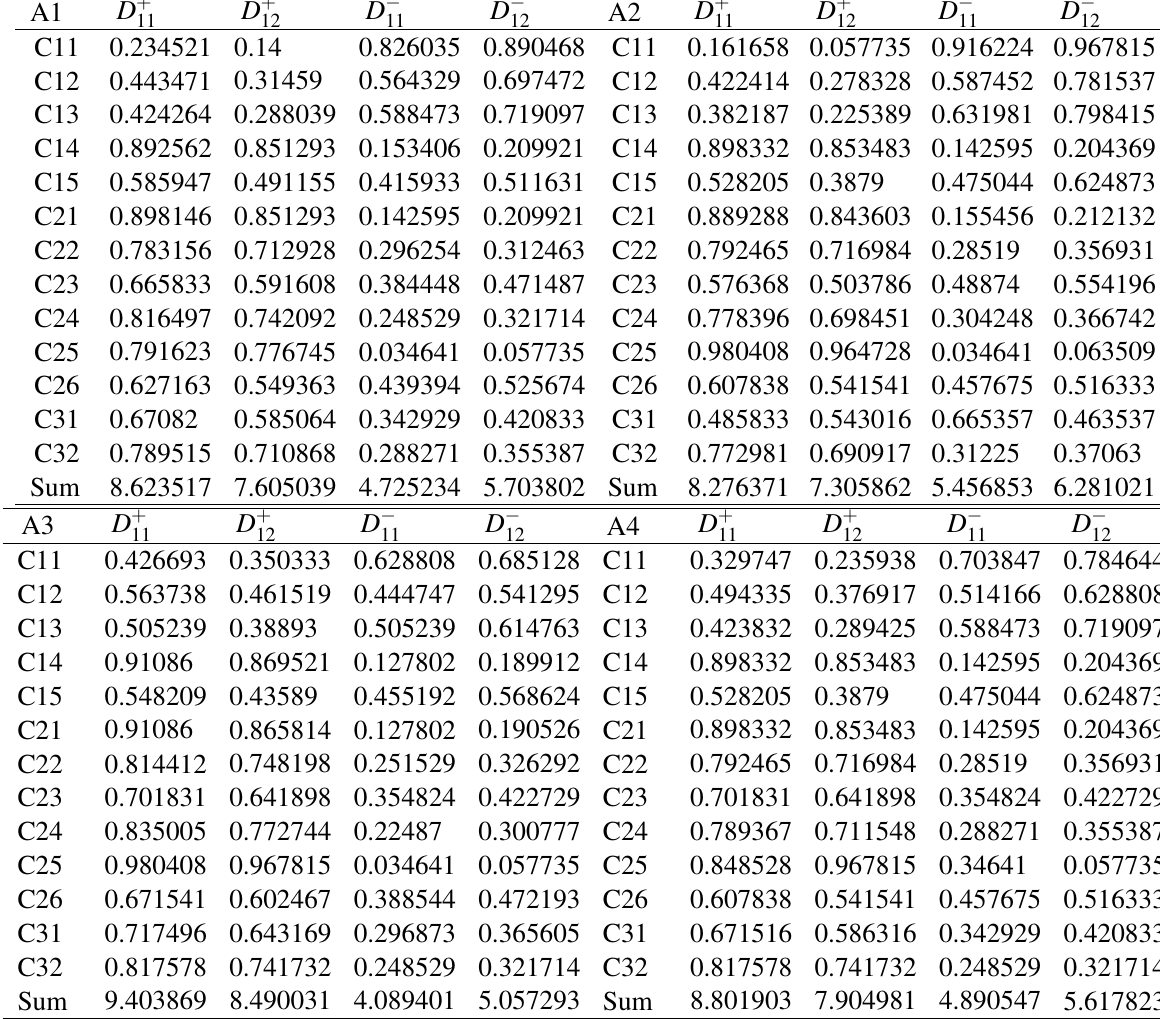
Table 11 Distance of alternatives from ideal alternatives